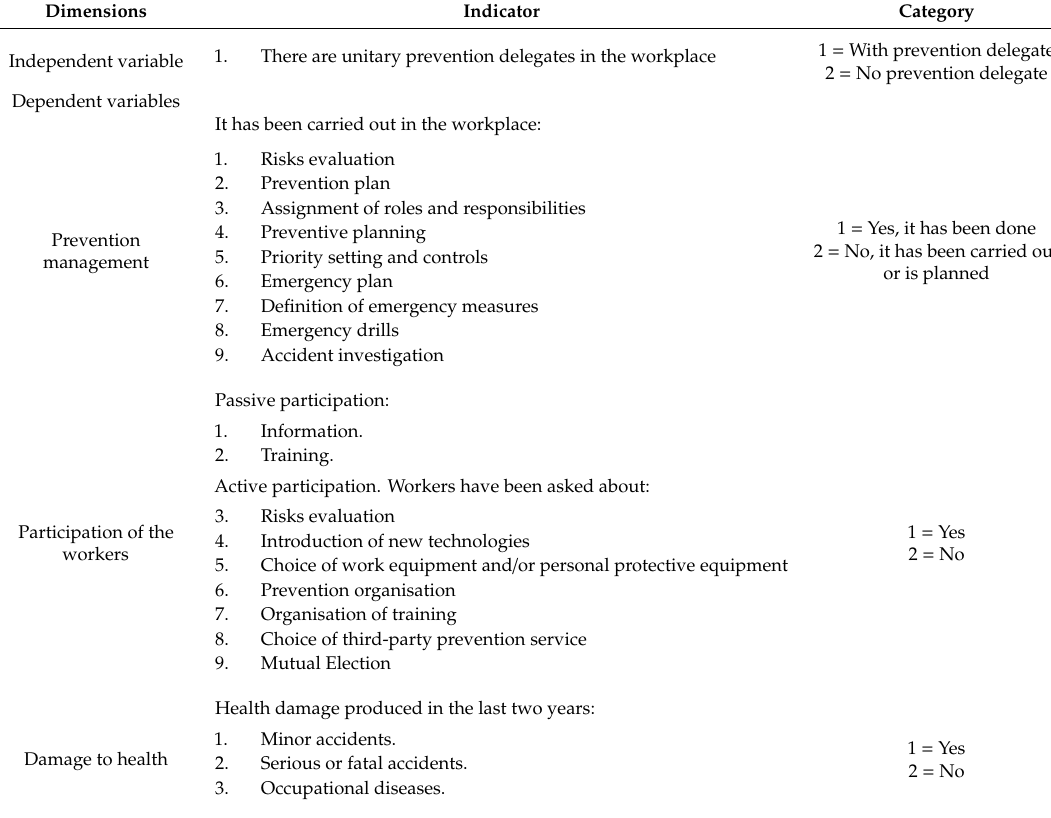
Table 2. Variables included in the